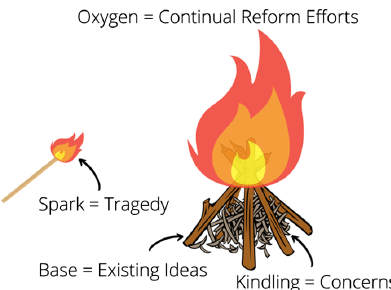
FIG. 5. Visual description of the bonfire